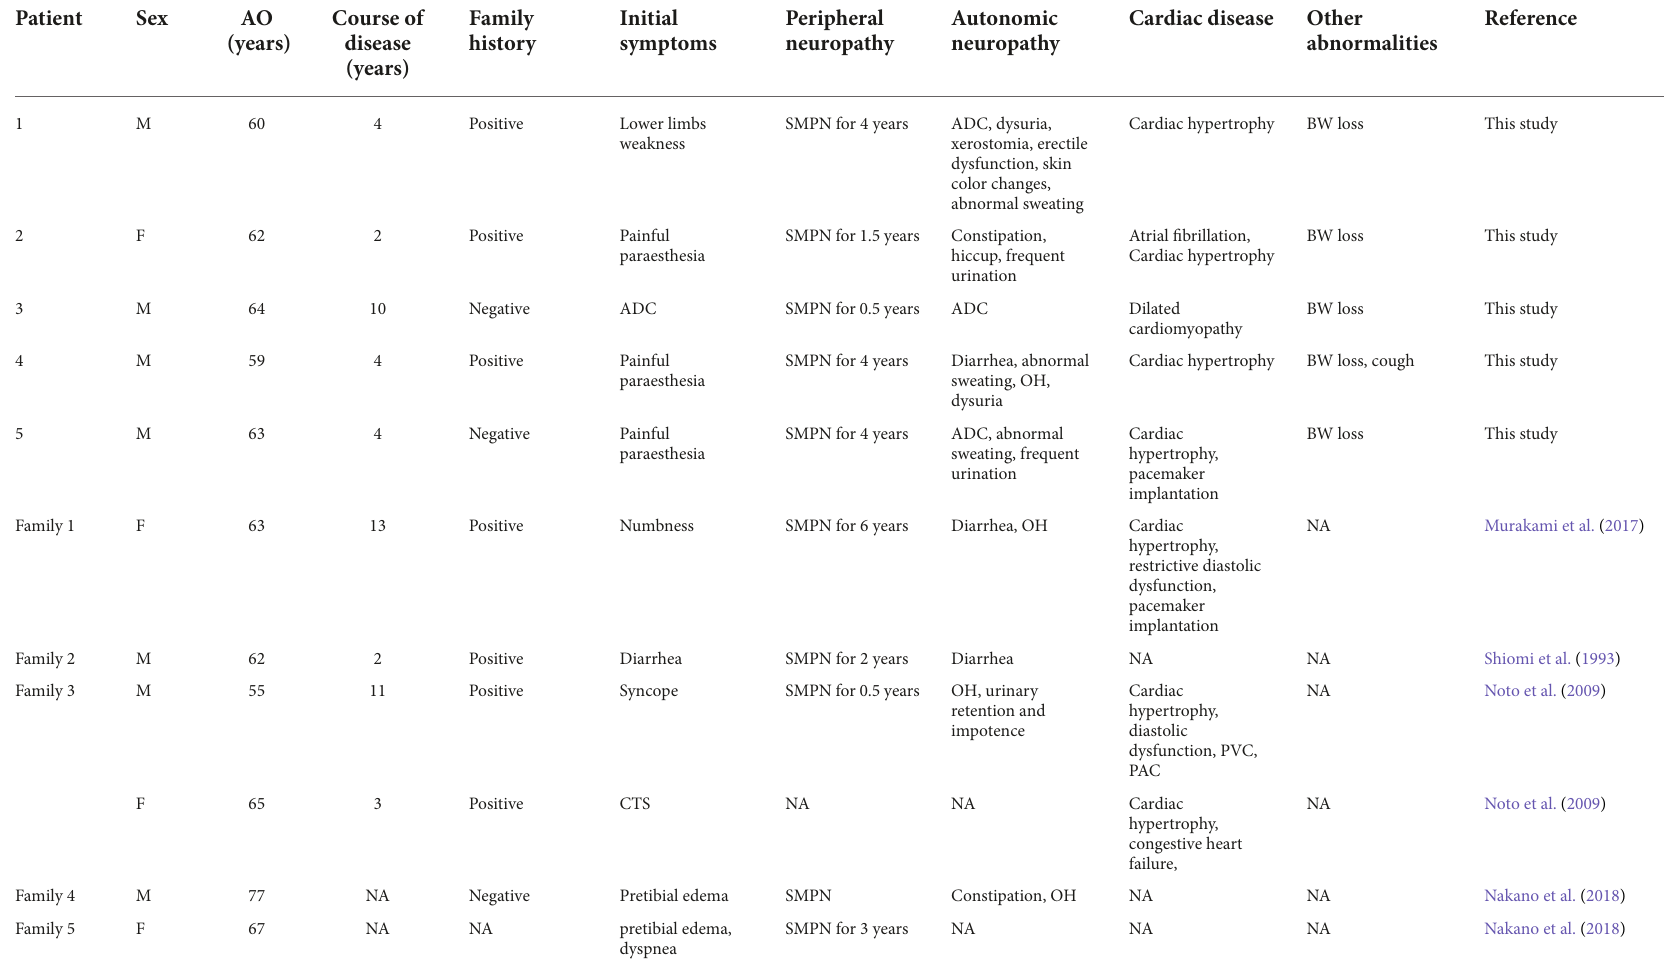
TABLE 1 Characteristics of symptomatic Glu61Lys-related ATTRv patients in this study and